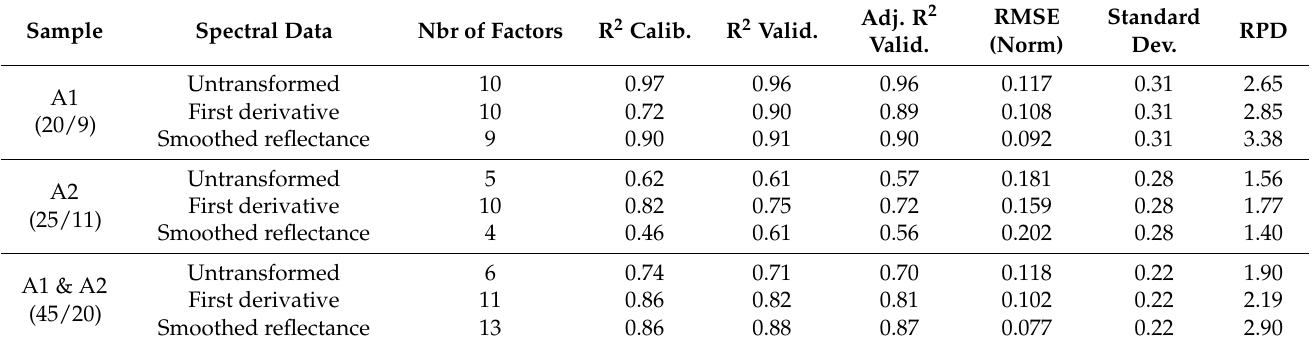
Table 5. PCR models for SOC prediction after selecting the spectral